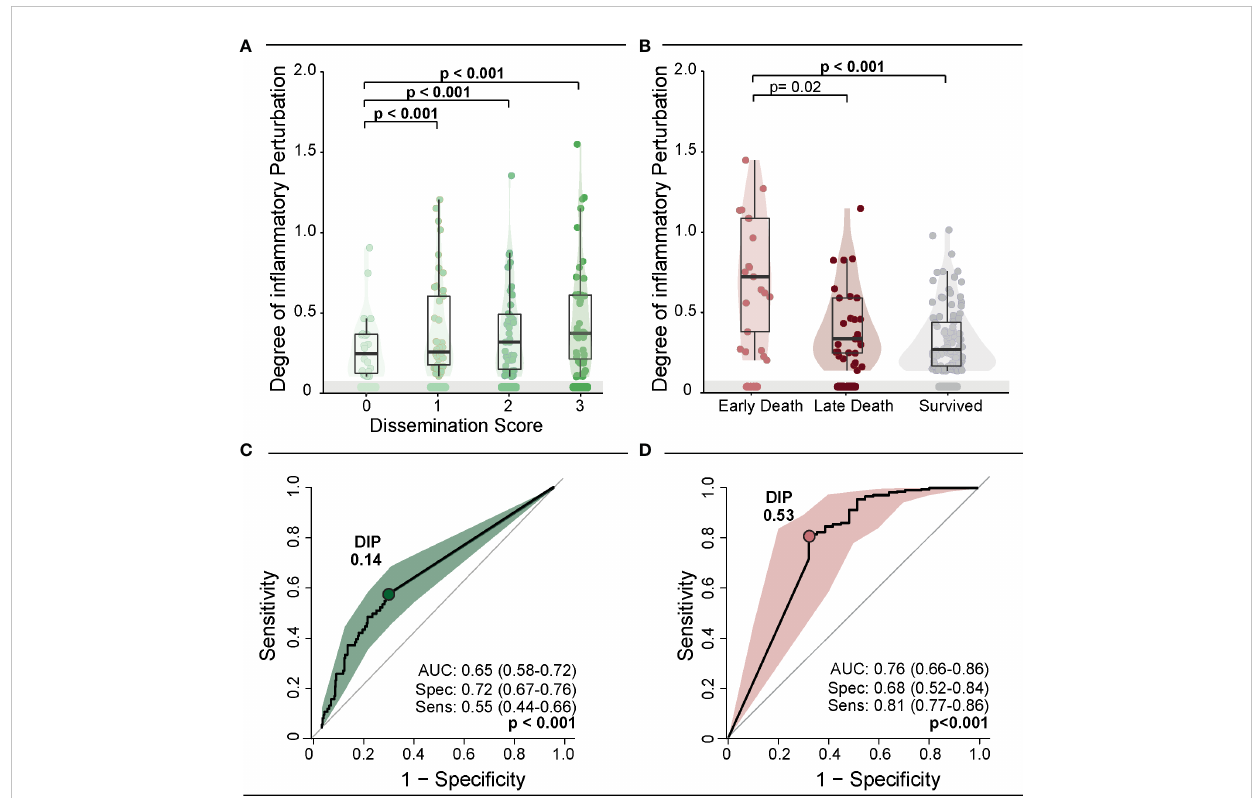
FIGURE 3 Degree of In fl ammatory Perturbation (DIP) according to dissemination score and death. (A) Scatter plots of the DIP value grouped according to dissemination score. Lines in the scatter plots represent median values and data were compared using the Mann – Whitney U test. (B) Scatter plots of the DIP value grouped according to death. Lines in the scatter plots represent median values and data were compared using the Mann – Whitney U test. (C, D) ROC curve analysis was used to evaluate the accuracy of DIP values to discriminate high dissemination score ( Mtb dissemination score 3) (C) and early death (D) . Colored dots indicate the cut-off values of DIP extracted from the ROC curve analyses that resulted in the optimal ratio between sensitivity and speci fi city; these values are described in the indicated